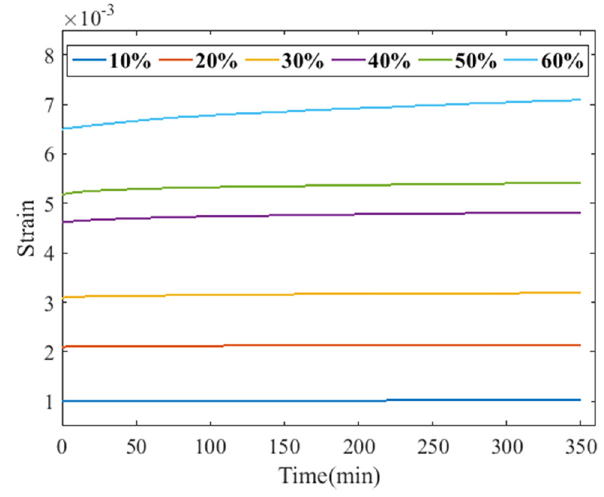
Figure 4: The strain history during the creep experiment.